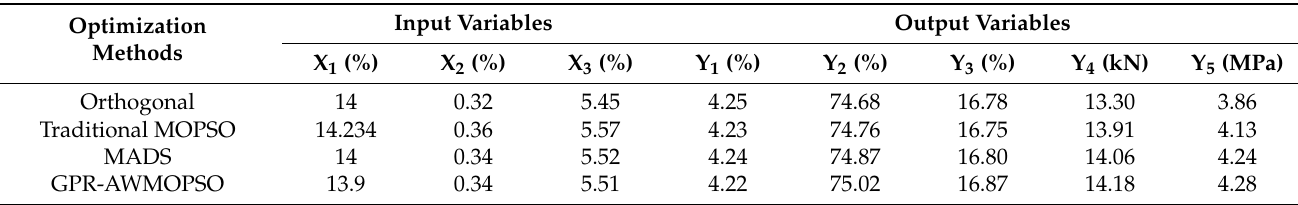
Table 10. Comparison of optimization results among the traditional orthogonal design [53], traditional MOPSO, MADS and GPR-AWMOPSO algorithm.